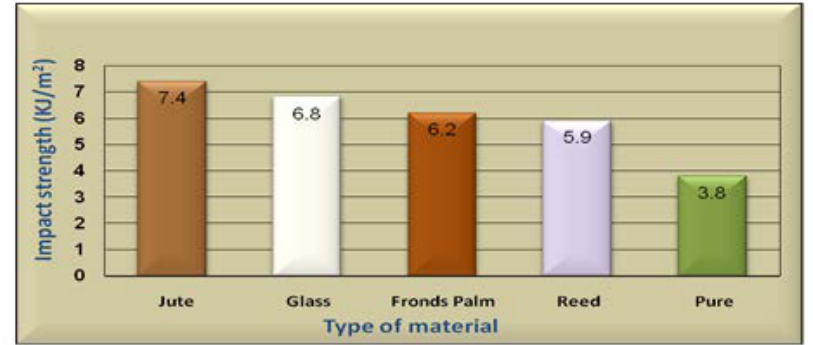
Fig. 5: The values of impact strength for the pure and composite materials.